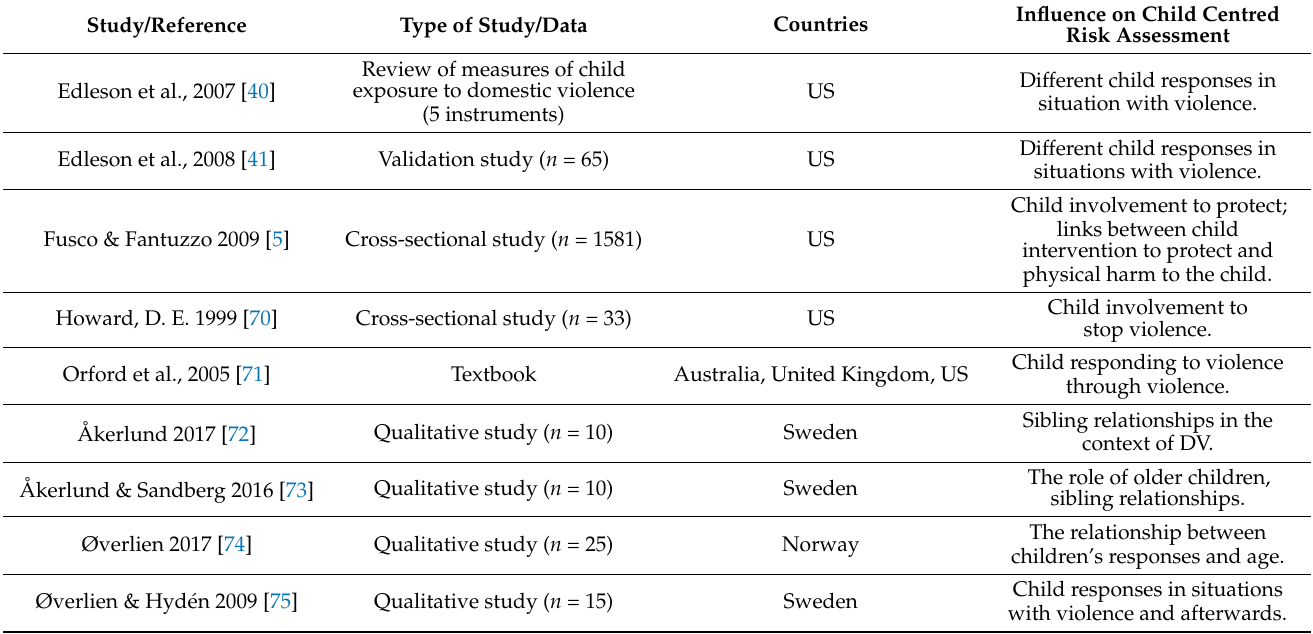
Table 2. The Child’s